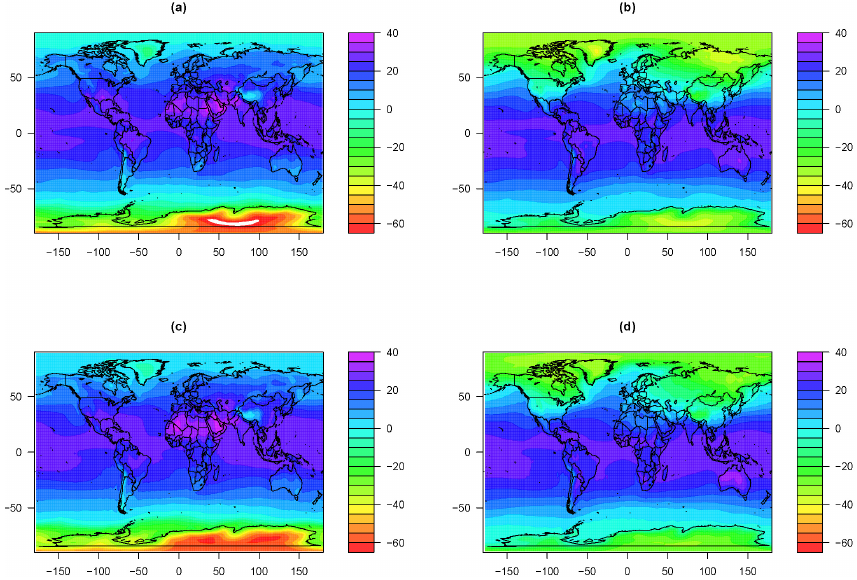
Figure 1. Temperature ( ◦ C) from GFDL for (a) JJA and (b) DJF, and from NCEP for (c) JJA and (d)